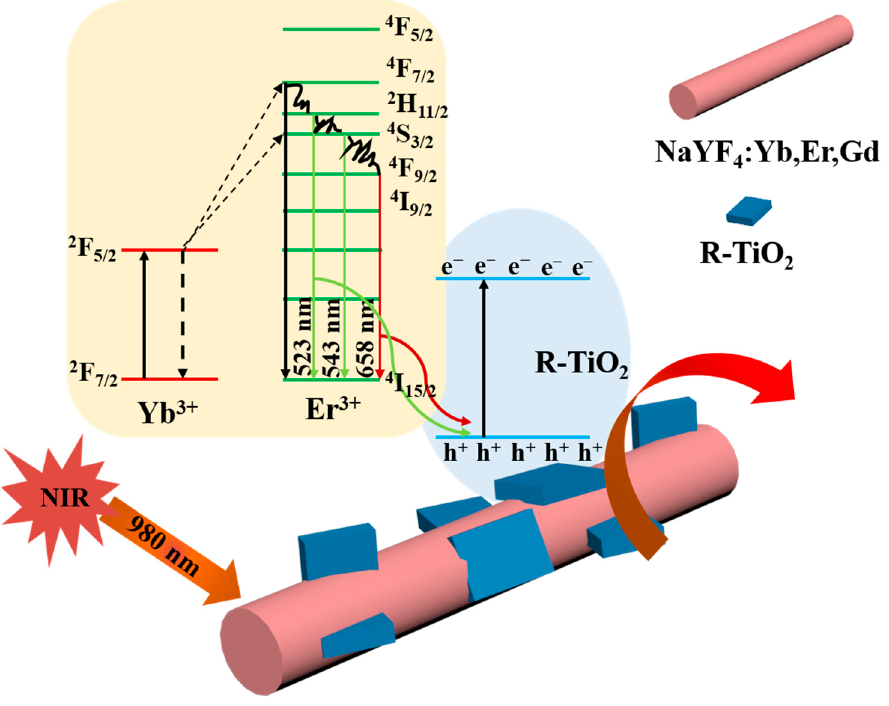
Figure 1. Schematic illustration of UCNPs@R-TiO 2 nanocomposite for photocatalytic sterilization under 980 nm NIR light irradiation.